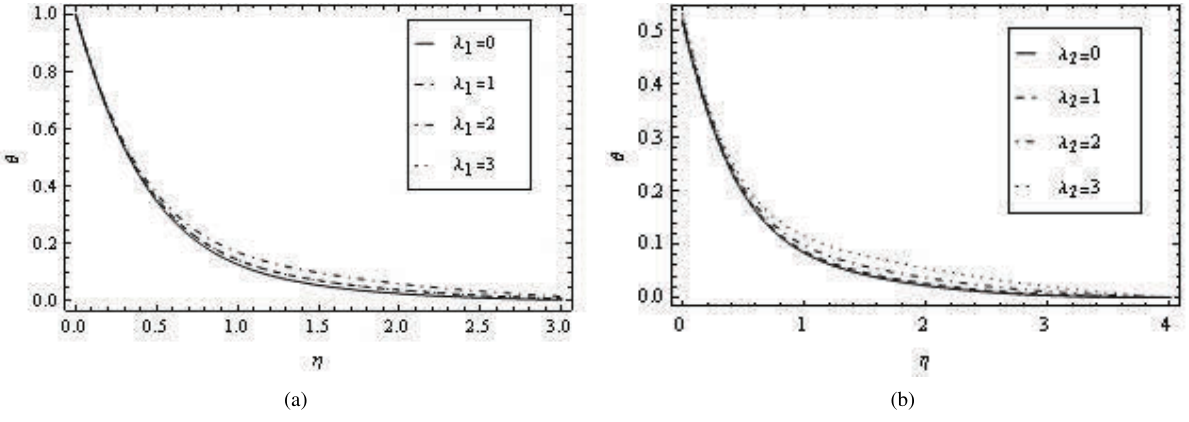
Figure 6. The effect of couple stress parameter (cid:21) 1 and (cid:21) 2 on temperature profiles when n D 1:25; ˇ D 0:4; E c D 0:5; P r D 3 and k D 1:5 (a) for PST and (b) PHF